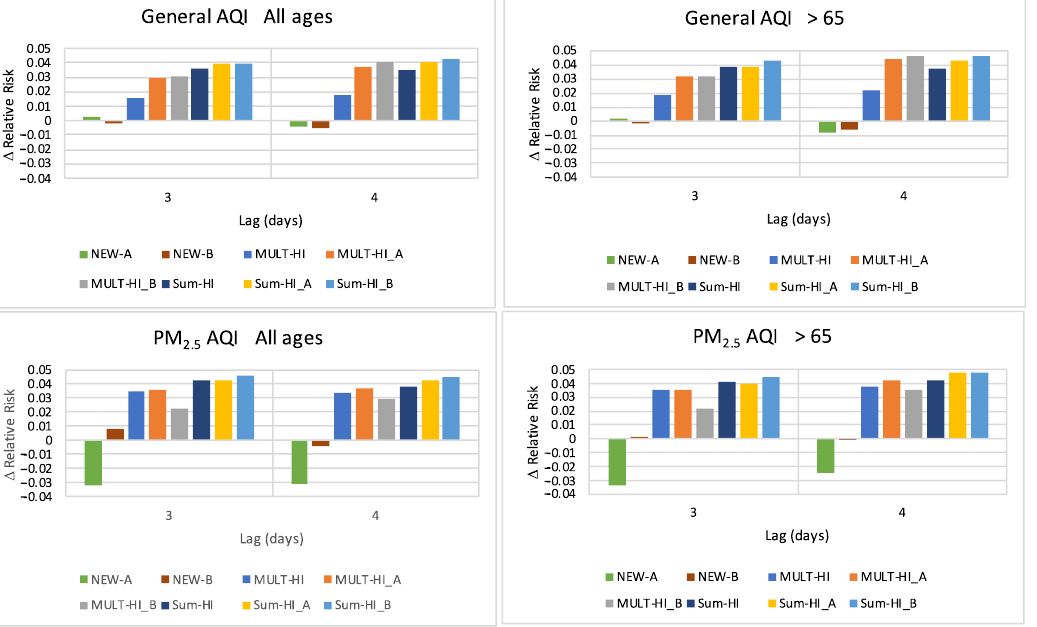
Figure 5. The increase in the interquartile relative risk over the baseline (AQI-only) model, for lags of three and four days. Model characteristics are described in Table 1. The observed increase in RR provided by models utilizing combined air quality and heat indices is consistent with the extensive literature describing multiple biological path- ways leading to deaths from respiratory and cardiovascular causes [32]. Examples include pulmonary inflammation and oxidative stress leading to hemostasis response [42] and pollution-mediated thrombosis through oxidative stress in concert with circulating mi- crovesicles [43], among others. 4. Conclusions Our results are generally consistent with prior publications which describe negative, synergistic short-term health impacts of air pollution and heat exposures. A unique aspect of this work is the development and testing of several types of combined air quality and heat indices, with their application to mortality in a major metropolitan zone. The results offer evidence that a combined index can communicate the interacting effects of air pollu- tion and heat more effectively than separate indices. Indices that combine air quality and heat information in additive and multiplicative manners provided notable improvements in predicting mortality. A chart depicting one such additive index is shown in Figure 6. The color of each region of health concern cor- responds to the ranges described in Figure 1. The chart is similar to the “urban climate index” for northwestern Europe [19]. Such a graphic, along with public communication